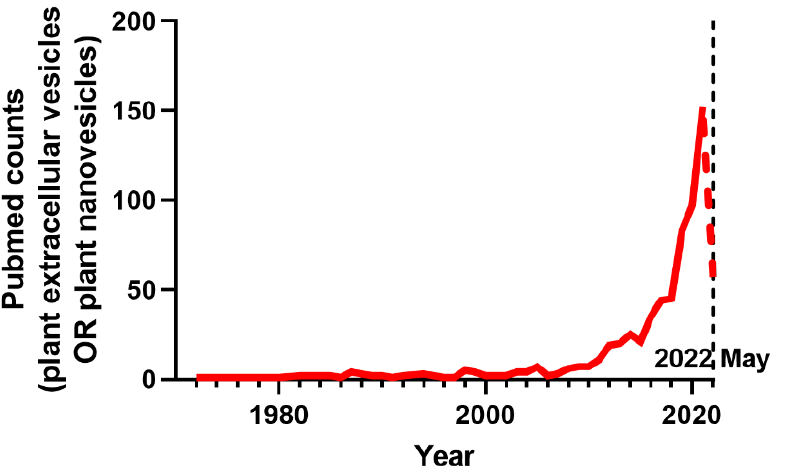
Figure 1. The number of publications per year in PubMed (https://pubmed.ncbi.nlm.nih.gov/ accessed on 1 June 2022) from 1972 to 2021 (as of May 2022). The field of PDNVs has evolved exponentially as shown by the number of publications searched by “plant extracellular vesicles OR plant nanovesicles”.